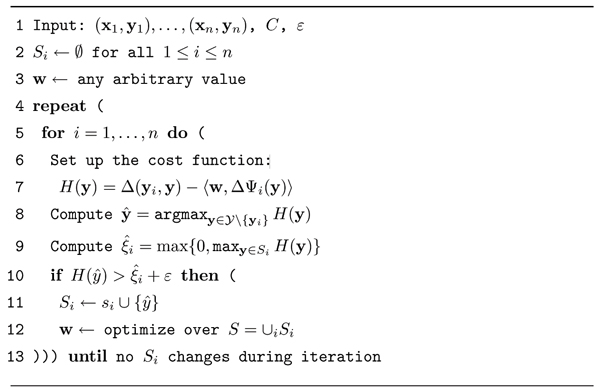
Algorithm for iterative constraint based optimization.